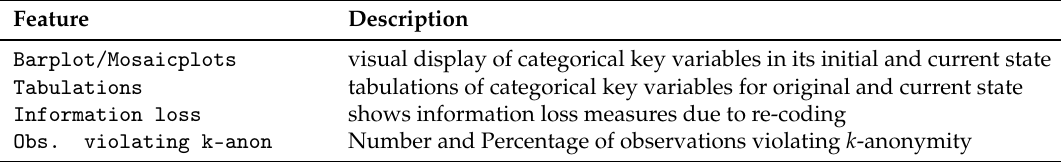
Table 8. Graphical and tabular comparison of anonymized vs. original